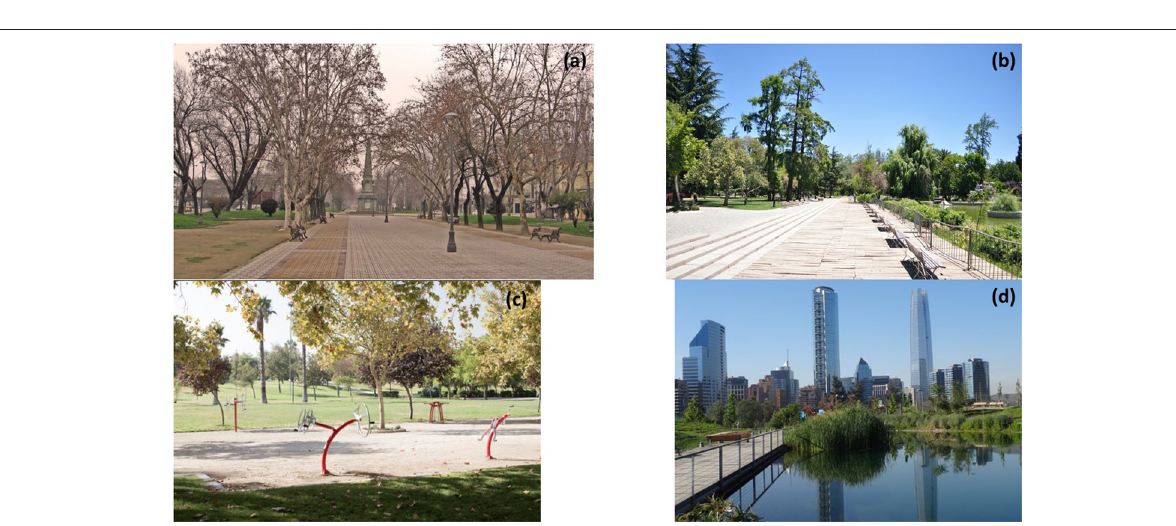
FIGURE 3 | Photos of Quinta Normal (b) , Andre Jarlán (c) , and Bicentenario (d) , and Cuatro Norte (a) Sources: (b) Wikimedia Commons https://commons. wikimedia.org/wiki/File:Parque_Quinta_Normal,_Santiago_de_Chile.JPG; (c) FAHNEU https://fahneu.cl/imagen/parque-andre-jarlan-pedro-aguirre-cerda; (d) TripAdvisor https://www.tripadvisor.com/ShowUserReviews-g294305-d3236426-r329849129-Parque_Bicentenario-Santiago_Santiago_Metropolitan_Region.html; (a) MAPIO